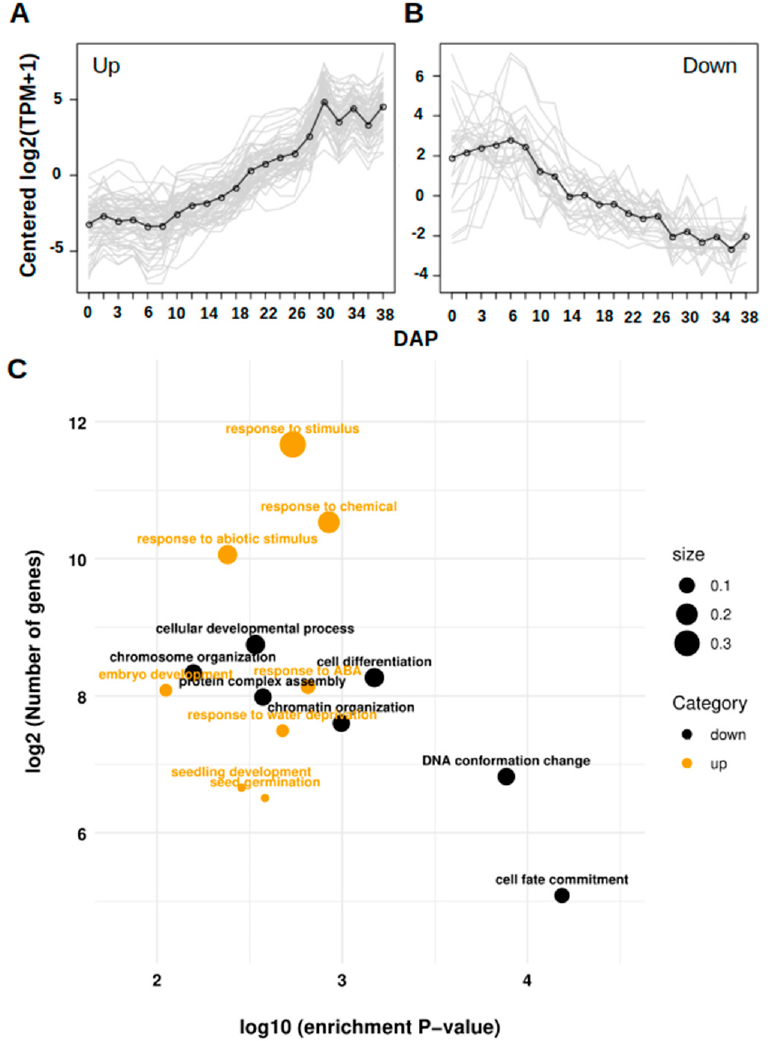
Figure 6. Gene expression profile of highly disordered IDPs with more than 75% of disorder in its sequence. ( A ) and ( B ) There is a group of IDPs which are induced and another group which are actively repressed throughout the period evaluated. ( C ) Functional enrichment analysis for each up and down-regulated gene encoding for highly IDPs. The size is proportional to the number of enriched genes among the total number of their GO term associated genes.